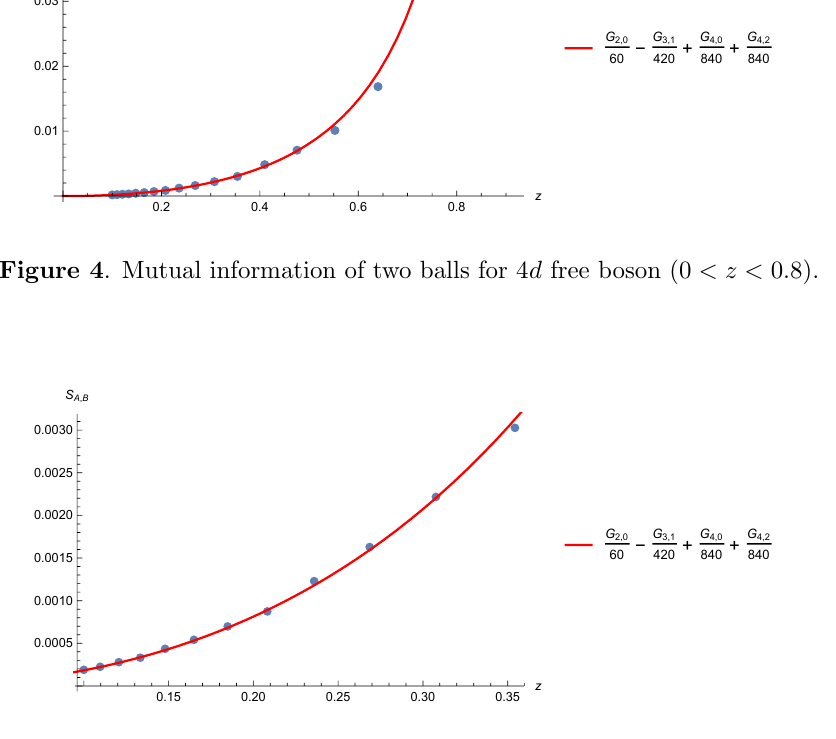
Figure 5 . Mutual information of two balls for 4 d free boson (0 < z < 0 :